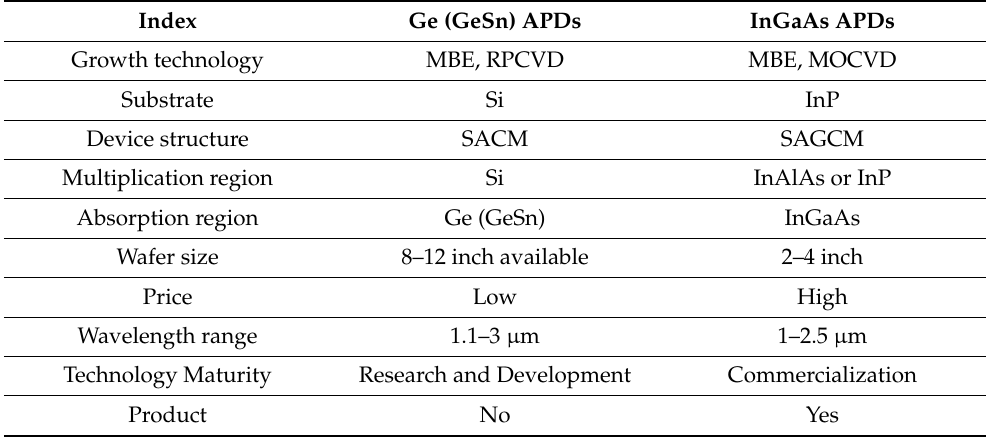
Table 3. Summarized evidence of the pros and cons for Ge (GeSn) and InGaAs APDs. Index Ge (GeSn) APDs InGaAs APDs Growth